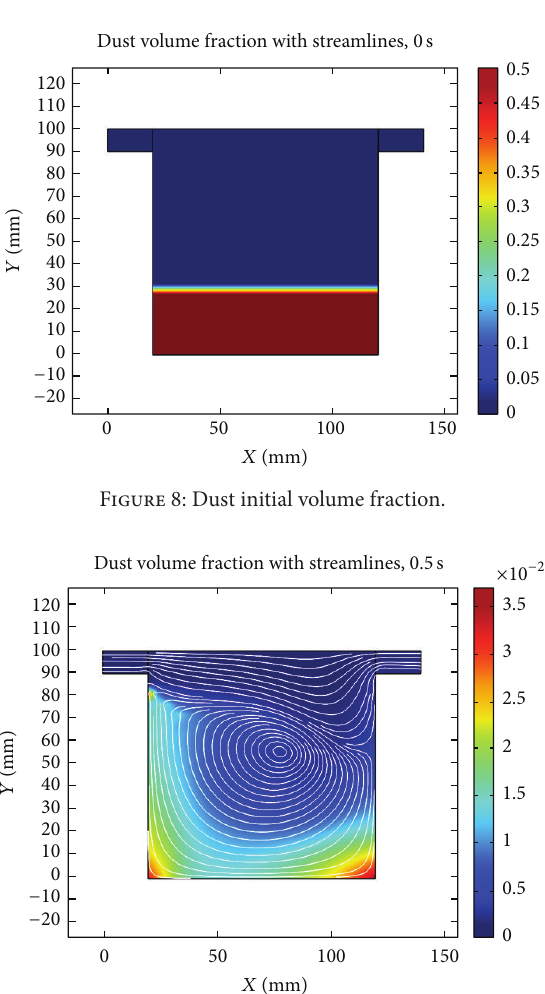
Figure 11: Normalised dust content versus